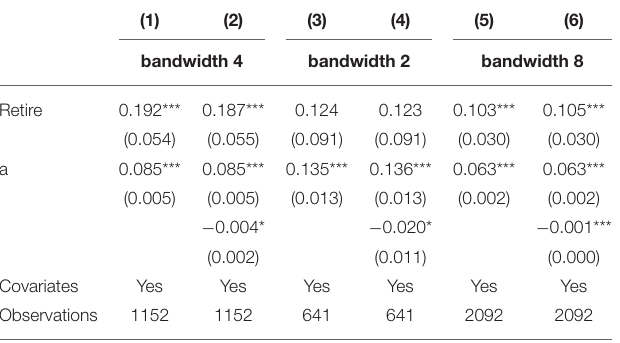
TABLE 9 | Analysis of mediation effect.